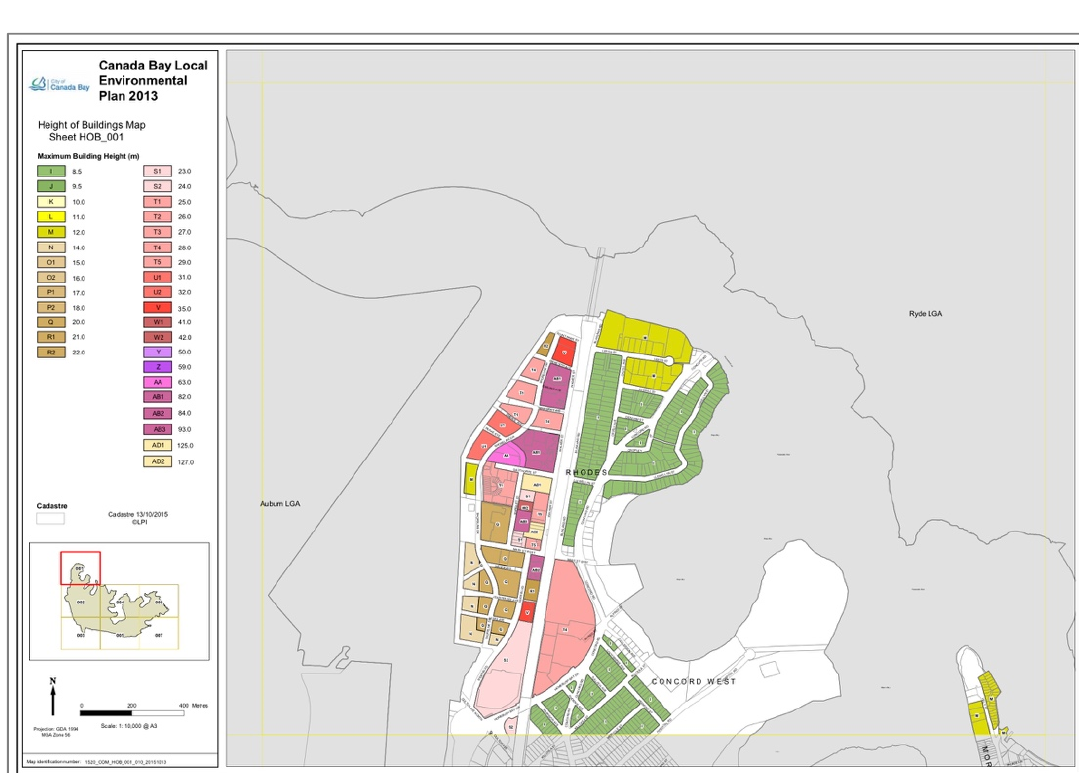
Figure A9. Rhodes Height of Building LEP.